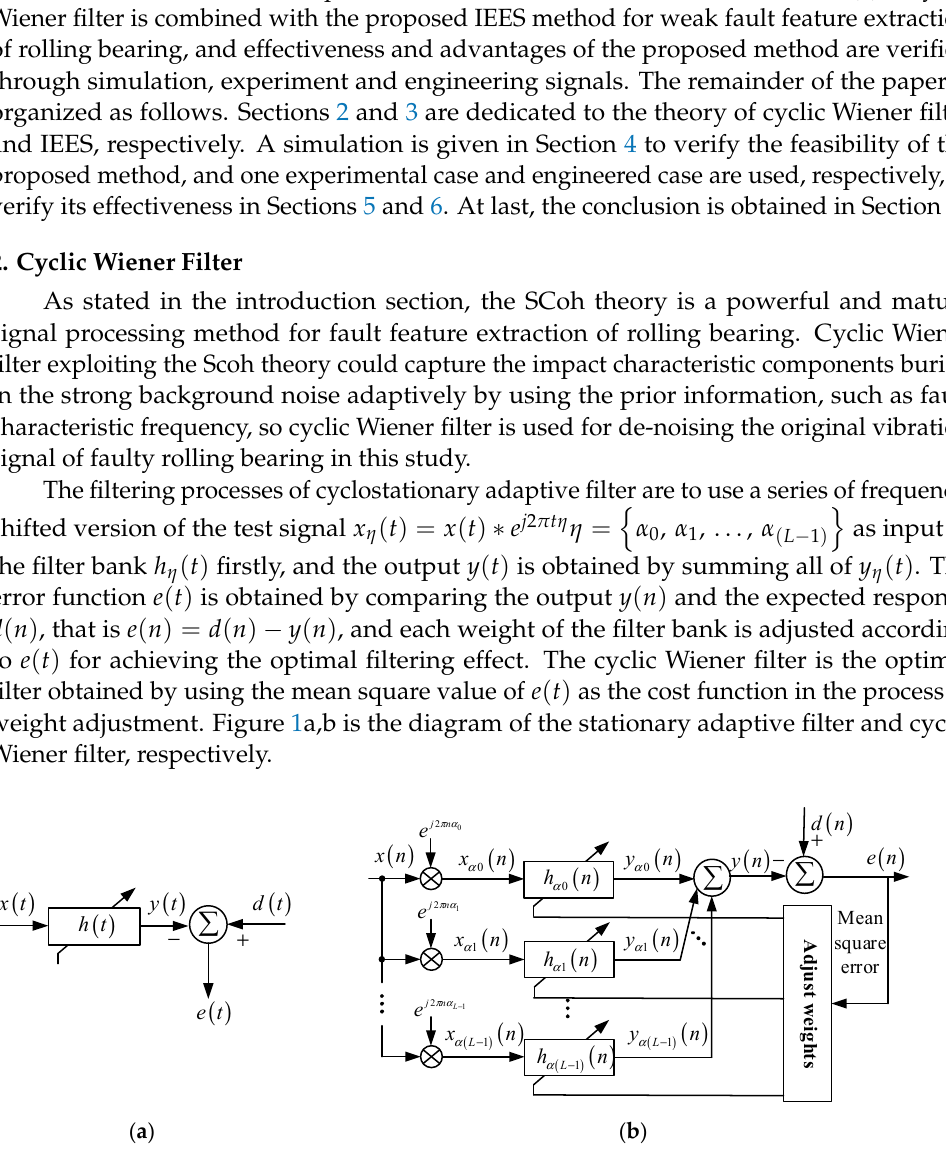
Figure 1. Diagram of the stationary adaptive filter and cyclic Wiener filter. ( a ) Diagram of stationary adaptive filter. ( b ) Diagram of cyclic Wiener filter.